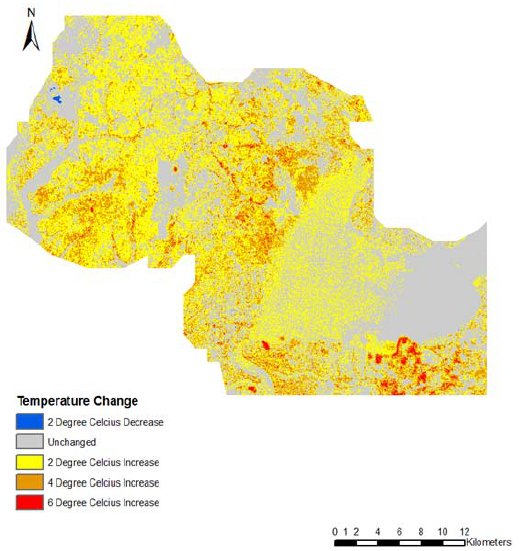
Fig. 6: Change in LST between 2002 and 2013